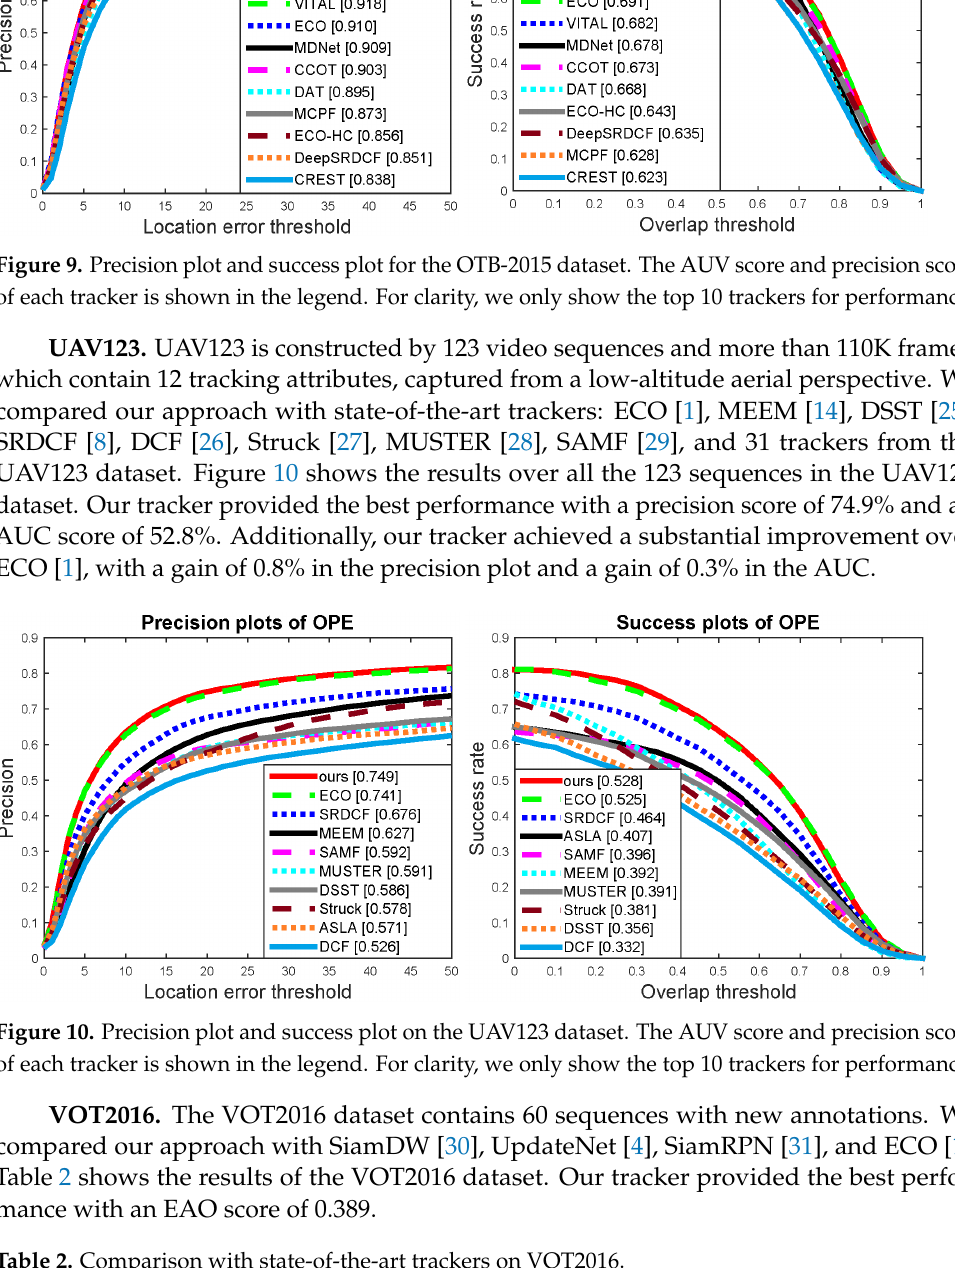
Table 2. Comparison with state-of-the-art trackers on